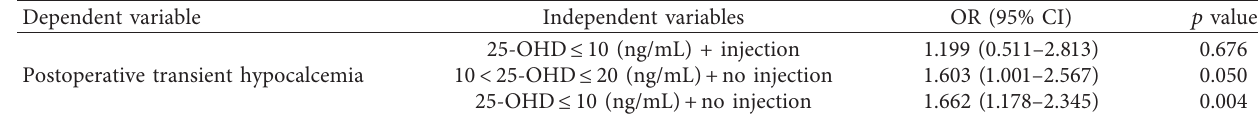
Table 8: Linear logistic regression